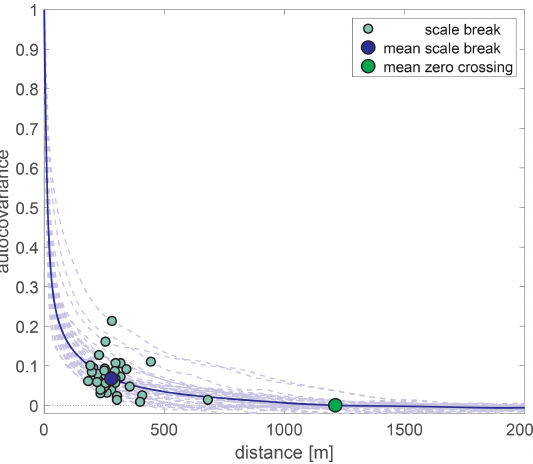
Figure 7. FFT-derived autocovariances for spatial snow depth. Indi- vidual ranges, mean range and mean autocovariance zero crossing are